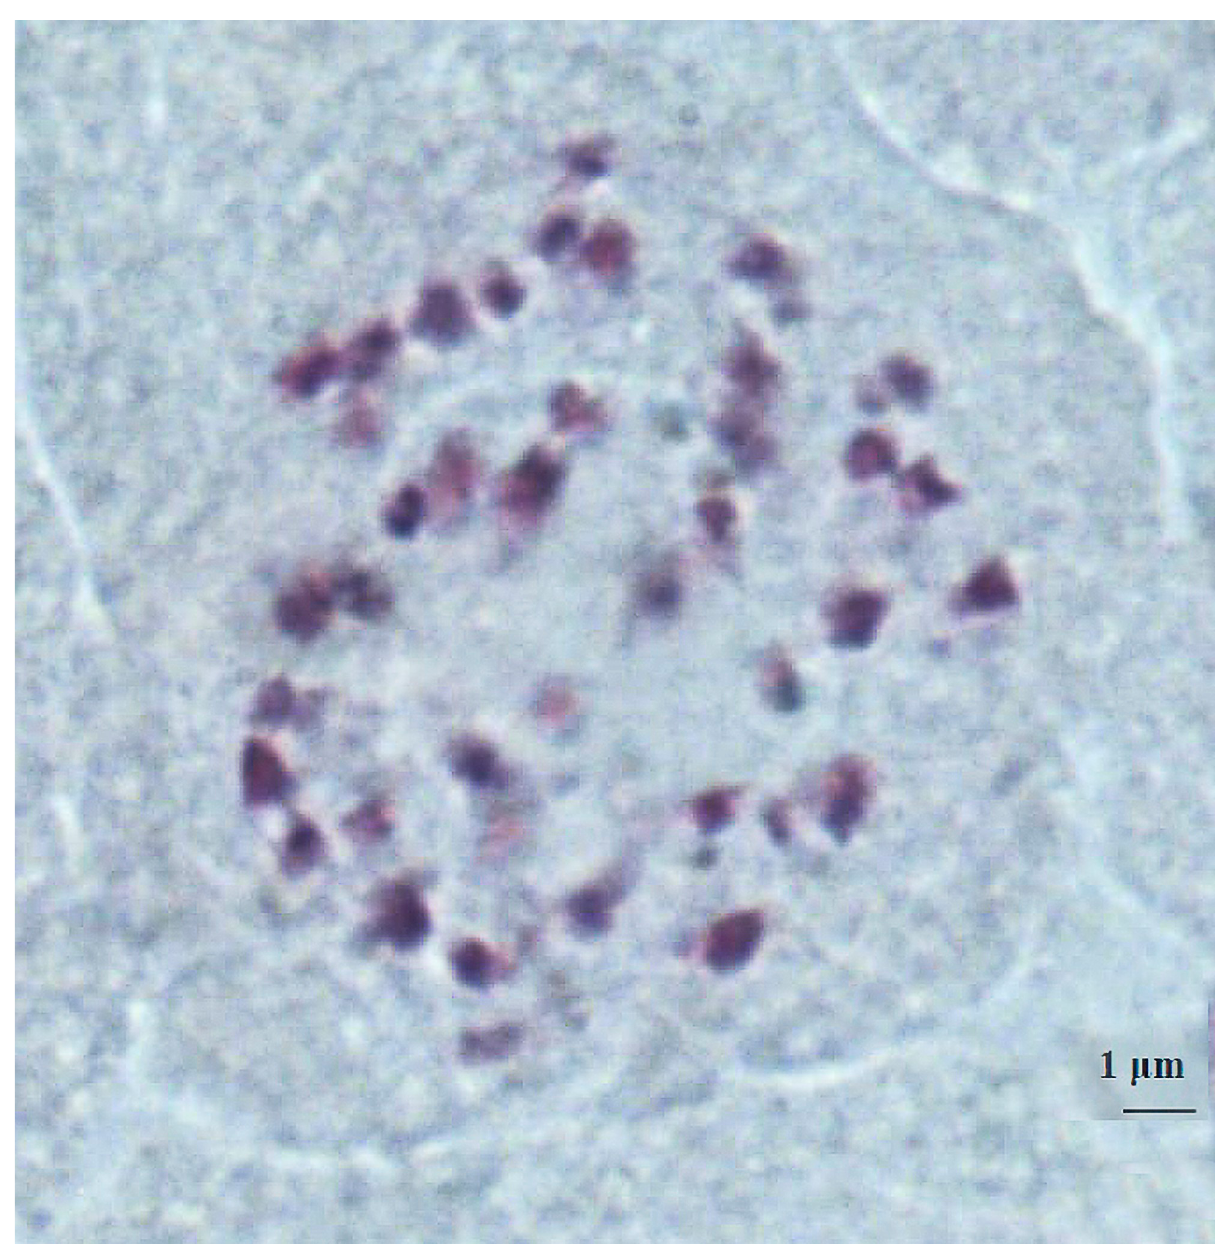
Fig 13. Chromosomes at somatic metaphase (Feulgen staining) of × Pseudorhiza nieschalkii nothosubsp. siculorum hybrid 2n = 40 ( ± 2), no. 28–2 (Fig 12); no. 30–1 (Fig 13); no. 31–4 (Fig 14). Scale bar = 1 μ m. Description. Stem 28.5 centimetres, 3.2 millimetres in diameter, devoid of anthocyanins. Basal sheath present. Sheathing leaves 4, evenly distributed evenly on the stem, angled, laterally spreading, narrowly lanceolate, longest leaf 65 millimetres long, widest leaf 11 millimetres wide, longest placed basally/base of the stem. Leaves vivid green, unmarked, lacking pro- nounced apical hooding. Inflorescence 67 millimetres (23% of stem length), cylindrical, flat topped, fairly lax. Flowers 28. Labellum deeply three-lobed, width × length 5.1 × 4.2 milli- metres to central lobe, 3.9 millimetres to lateral lobes. Inter-lobe sinuses deep, c.2.1–2.3